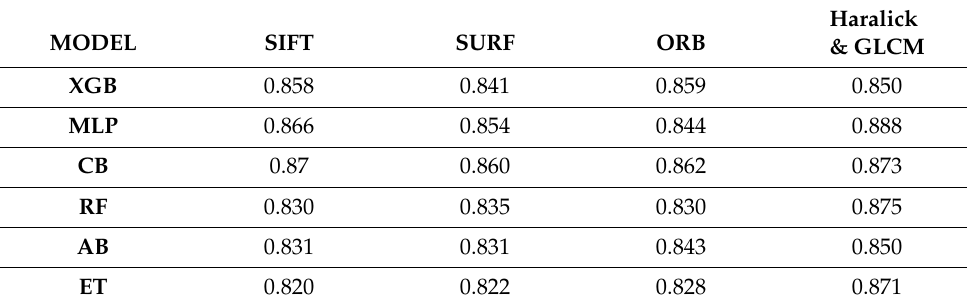
Table 3. The comparative performance of classifiers in terms of the accuracy used for the classification of IDC(+) and IDC(-) images using standalone descriptors.